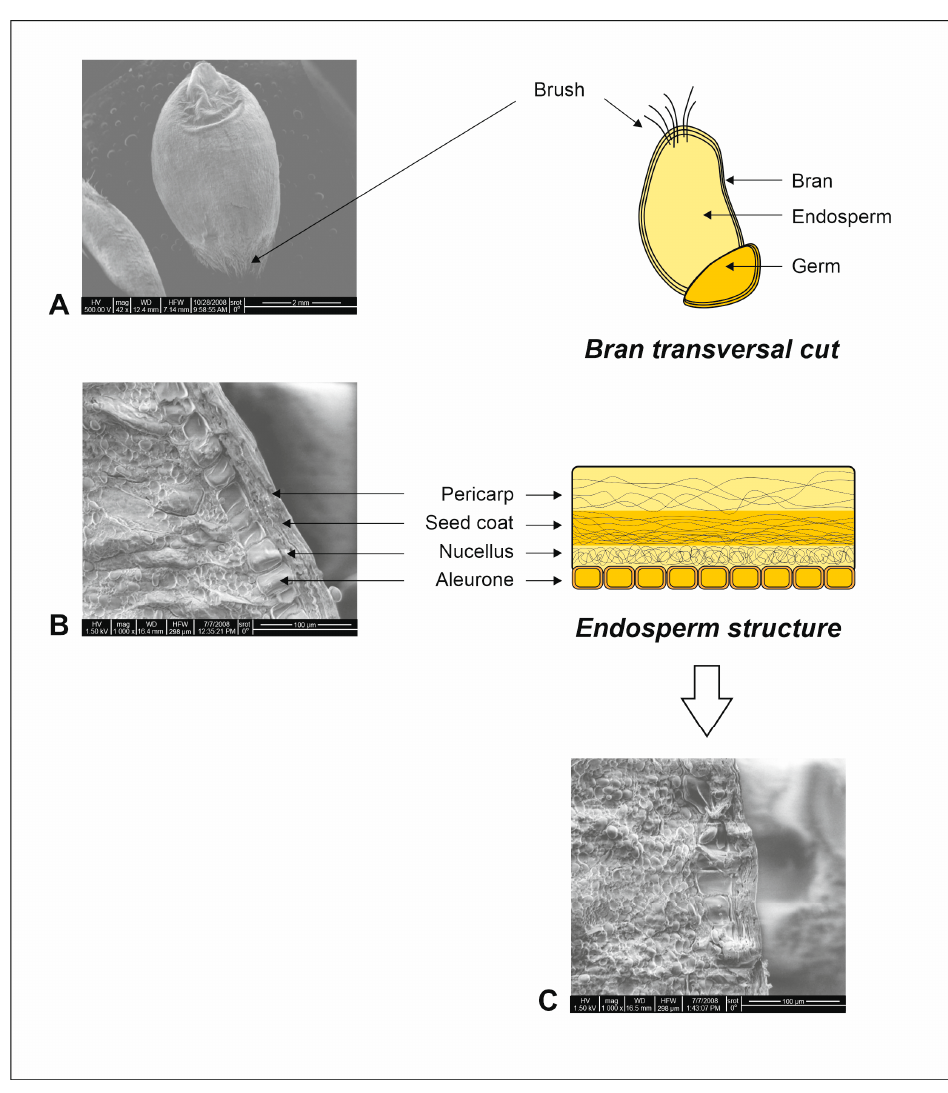
Figure 1. The wheat kernel shows the three major, distinct parts: germ, endosperm, and bran (pericarp), along with the bran transversal cut cross and endosperm structures. The wheat